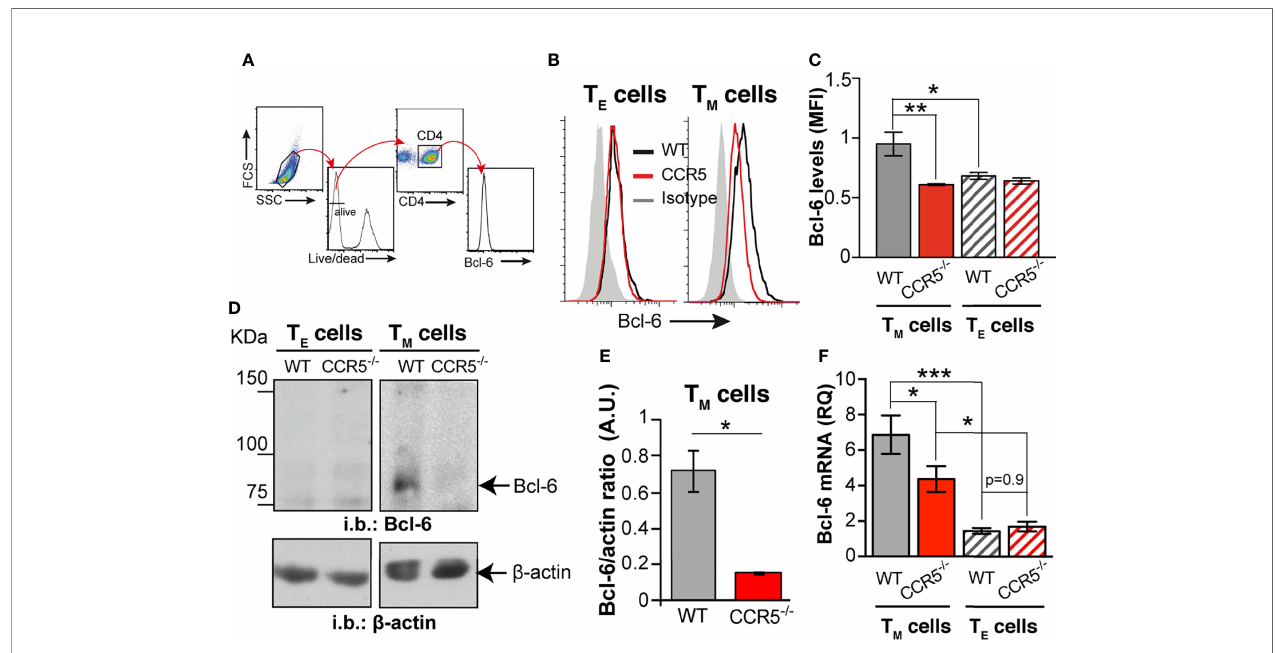
FIGURE 4 | CCR5 de fi ciency downregulates the glycolytic repressor Bcl-6 in CD4 + T M cells. (A) Gating strategy for determination of relative Bcl-6 levels by fl ow cytometry. (B) Representative histograms for Bcl-6 levels in WT (black lines) and CCR5 -/- (red lines) T E (left) and T M (right) cells; the isotype control histogram is also shown (gray). (C) Quanti fi cation of the mean fl uorescent intensity (MFI) for Bcl-6 staining in WT and CCR5 -/- T E (hatched bars) and T M (solid bars) cells ( n =3) (D) . Representative immunoblots of Bcl-6 and b -actin (loading control) in total cell extracts from WT and CCR5 -/- T E and T M cells ( n =3). (E) Bcl-6: b -actin densitometry ratio from immunoblots as in (A) . (F) Relative expression of Bcl-6 mRNA in WT and CCR5 -/- T E (hatched bars) and T M (solid bars) cells ( n =12). Data are means ± SEM. ***p < 0.001, **p < 0.01 *p < 0.05, two-tailed Student t test (E) , or two-way ANOVA with Bonferroni post-hoc test (C, F)